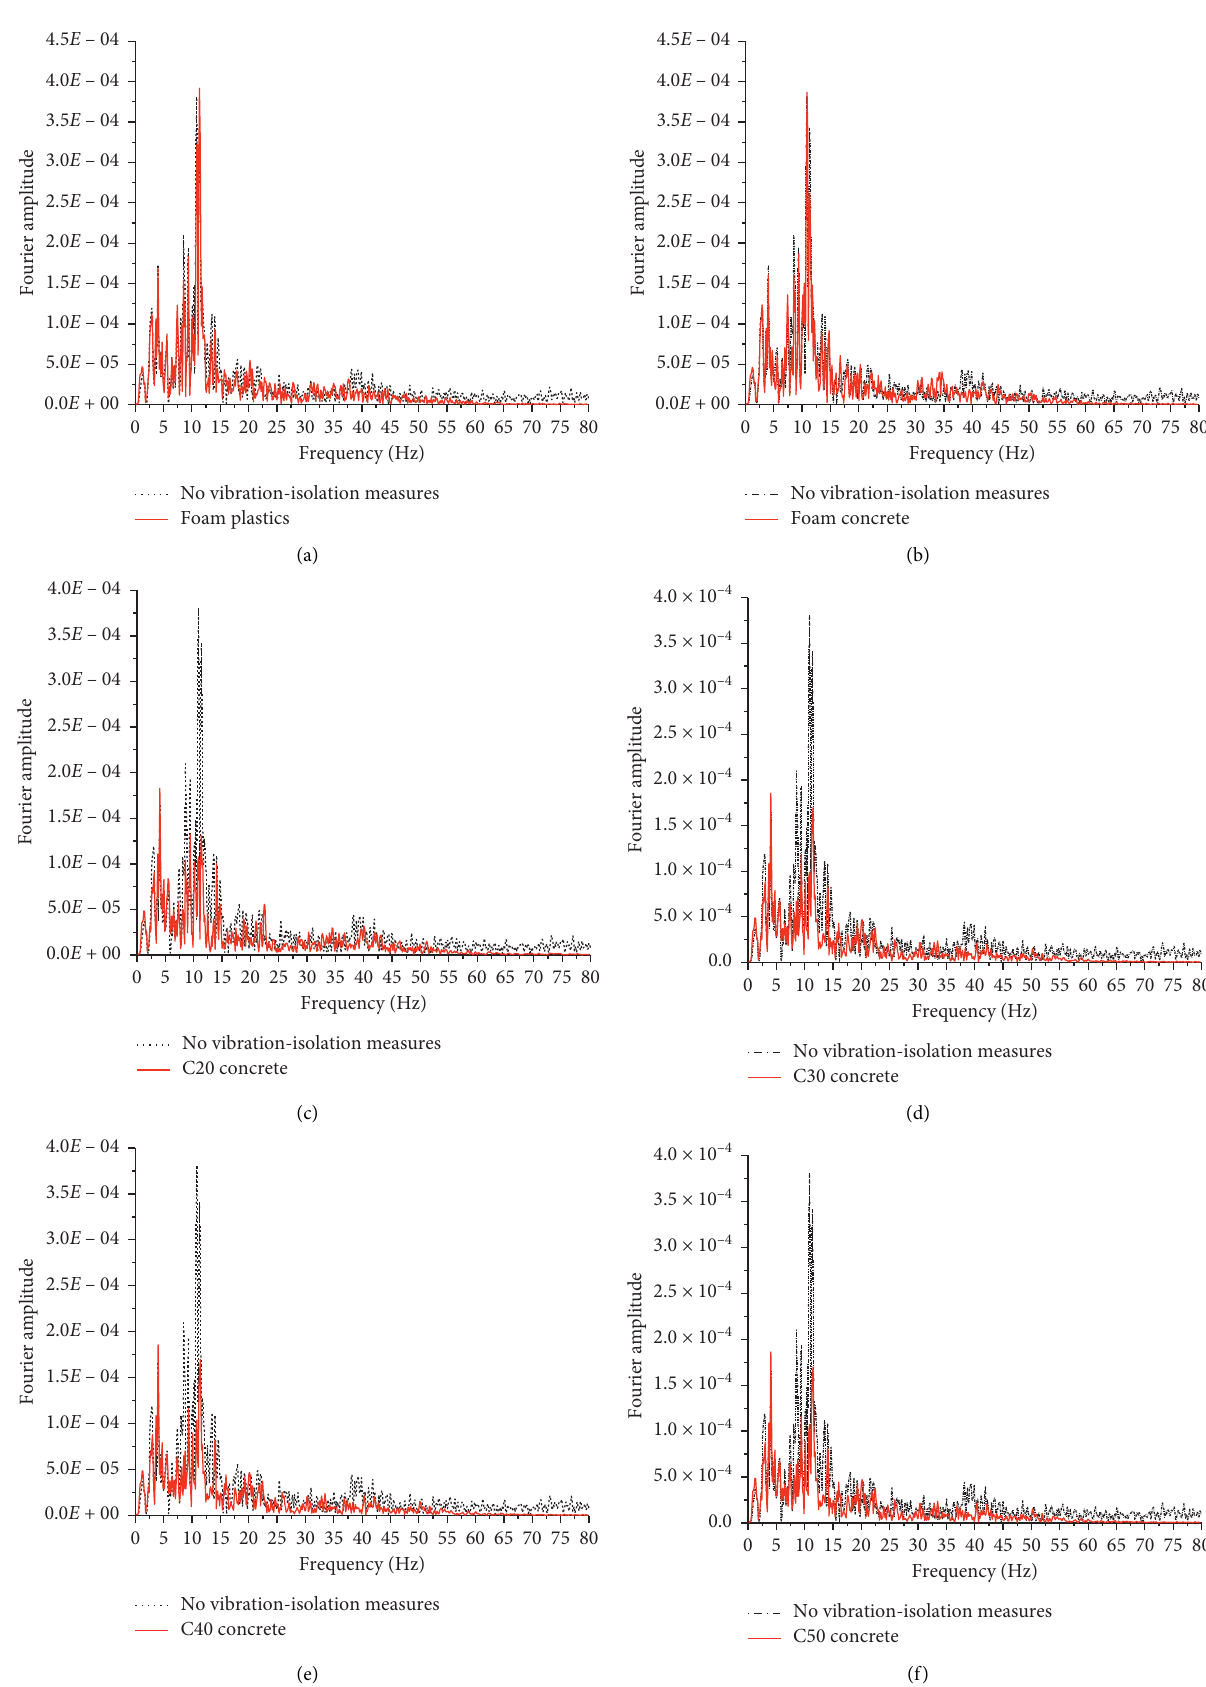
Figure 29: Influence of pile material on vibration-isolation effect (comparison of frequency